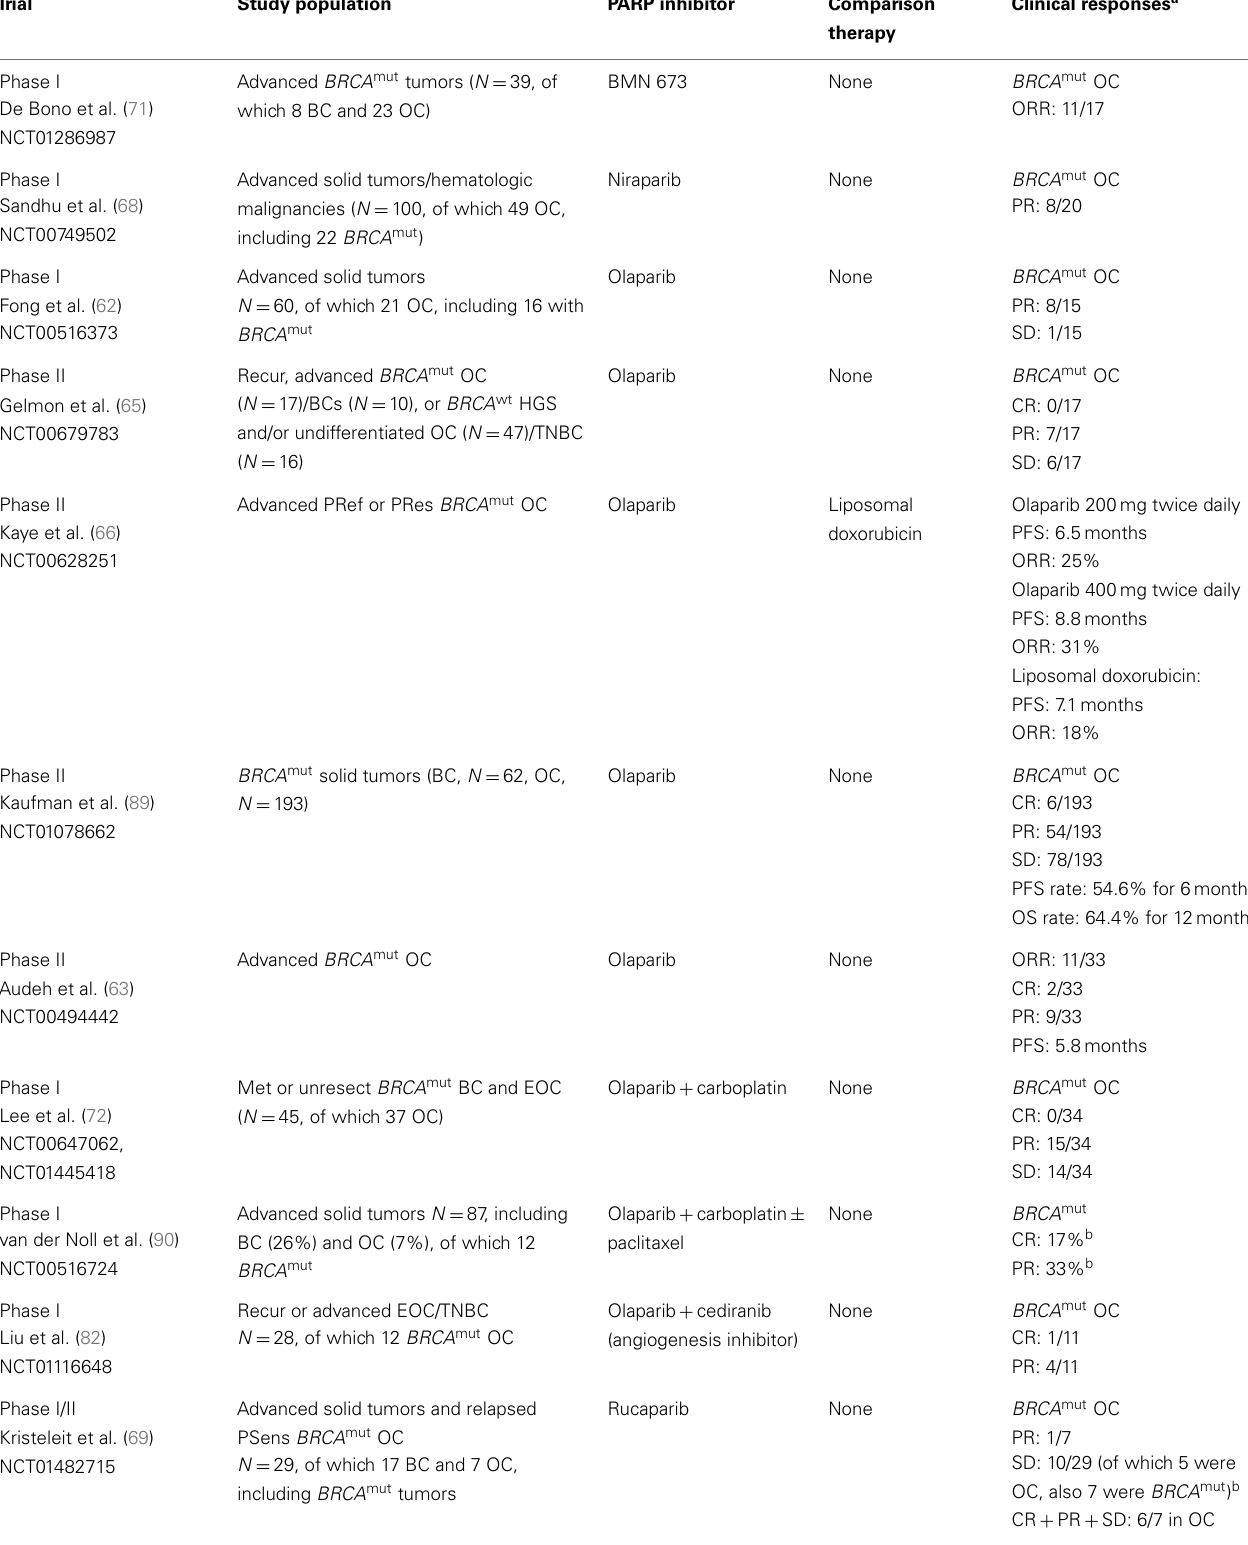
Table 2 | Selected PARP inhibitor trials in BRCA 1/2 -mutated ( BRCA mut ) ovarian cancers